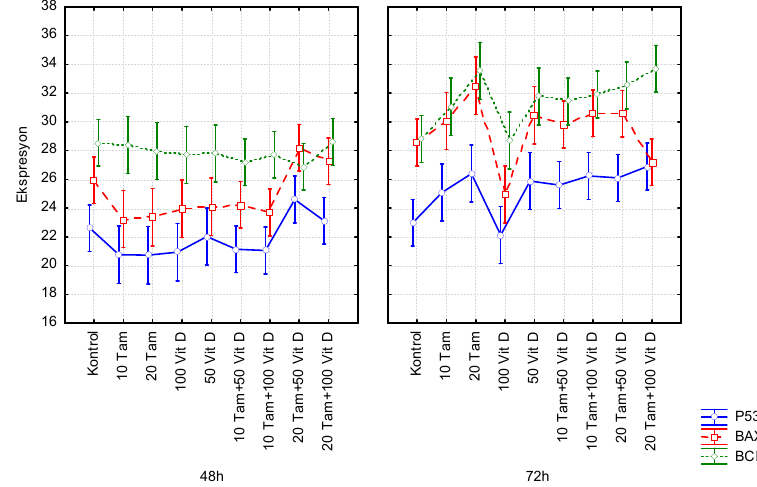
Figure 2. Evaluation of the effects of Tamoxifen (TAM) or vitamin D (Vit D), and combinations of both for 48th and 72nd h on the P53, BCL2 and BAX expression levels using